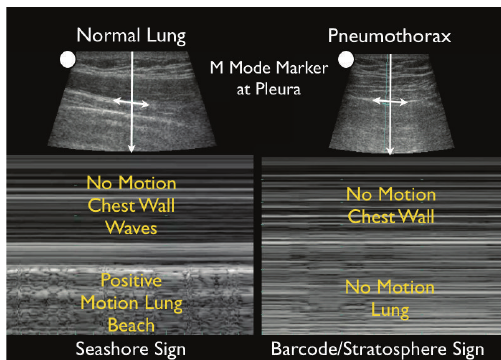
Figure 22: M-mode of normal lung versus pneumothorax.